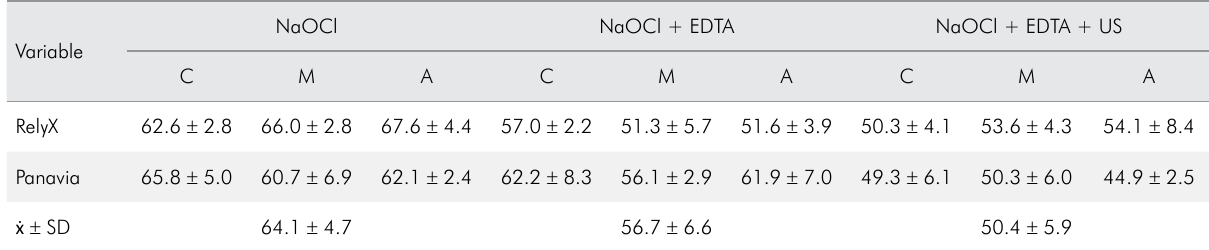
Ẋ ± SD = Mean ± standard desviation; C: coronal third; M: middle third; A: apical third.